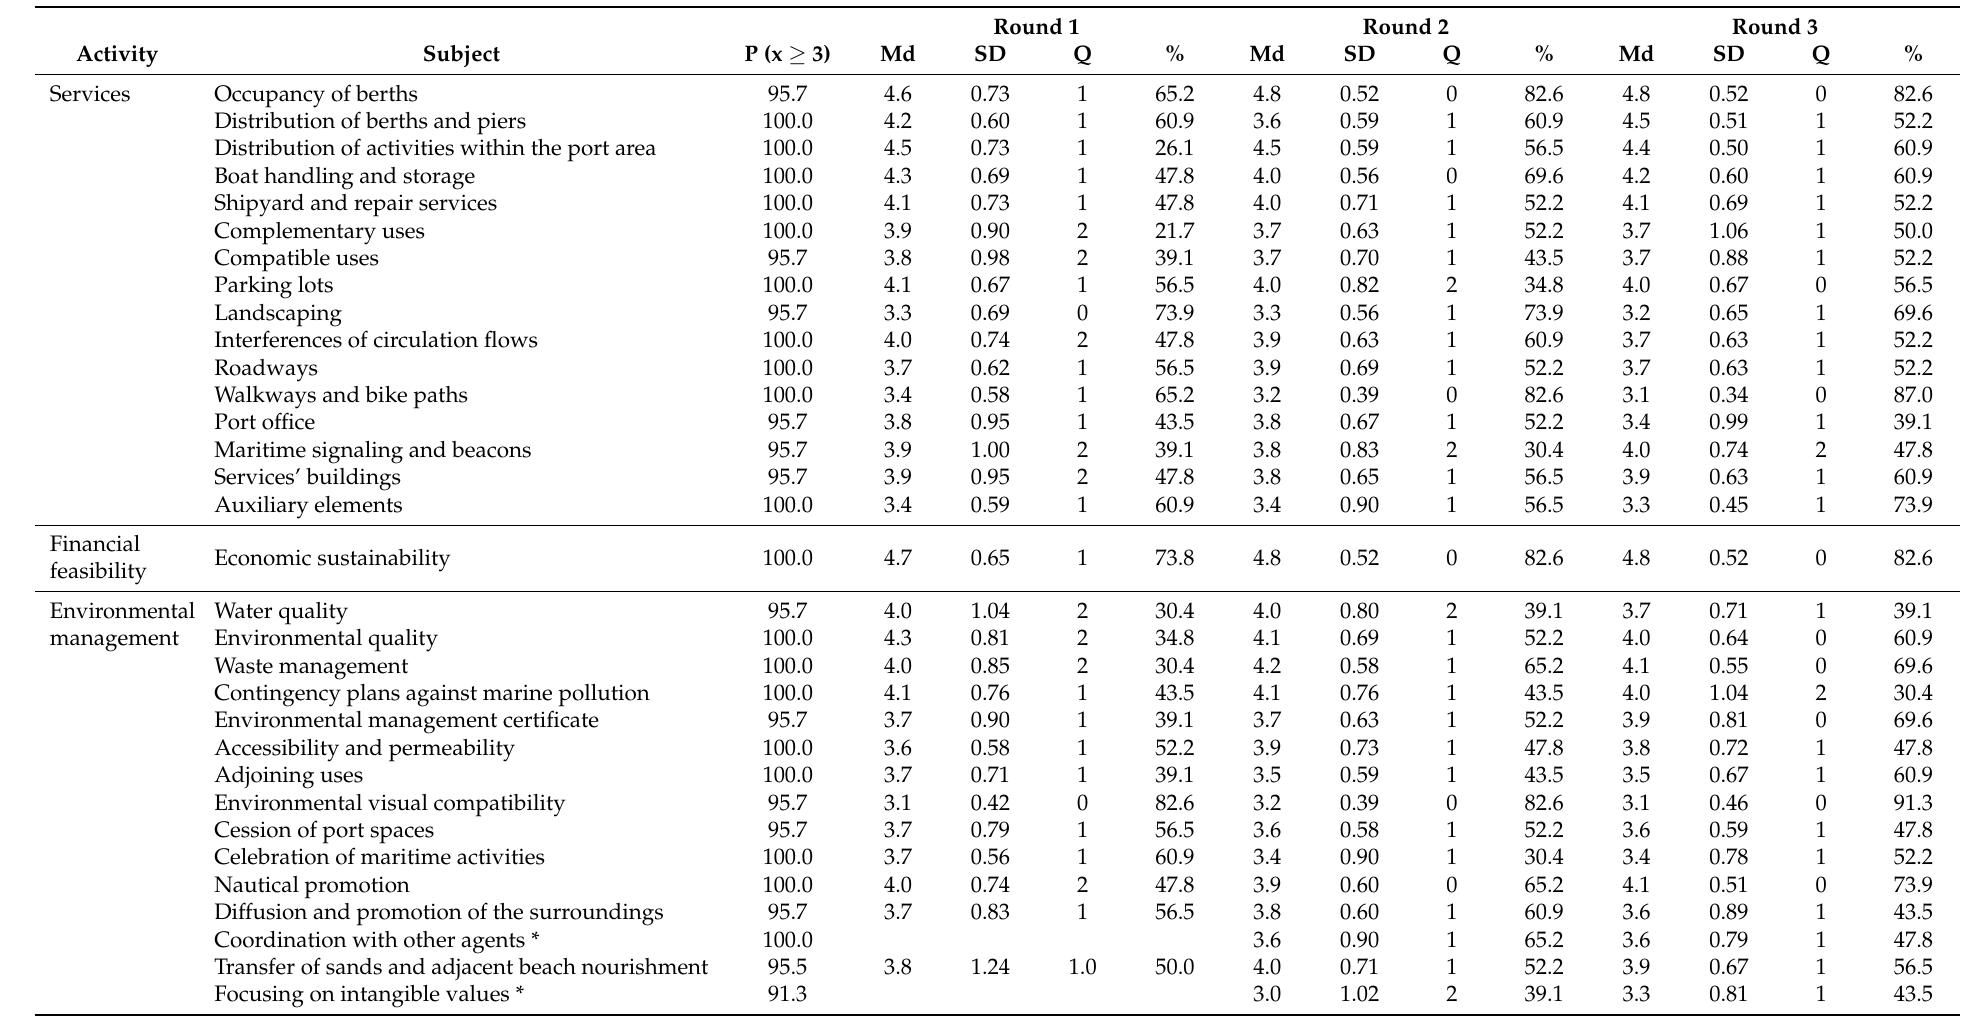
Table A1. Statistical results from rounds related to management of marinas (Delphi